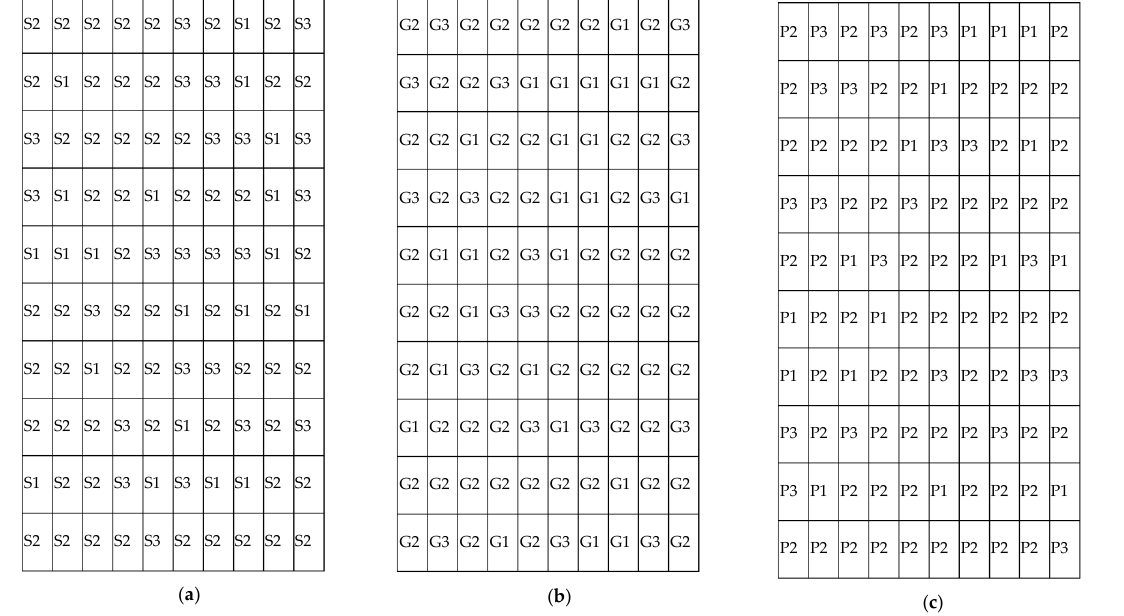
Figure 2. Spatial distribution of three land use types and spatial distribution of indexes. Table 1. Three spatial entity attribute membership degree comparison table.